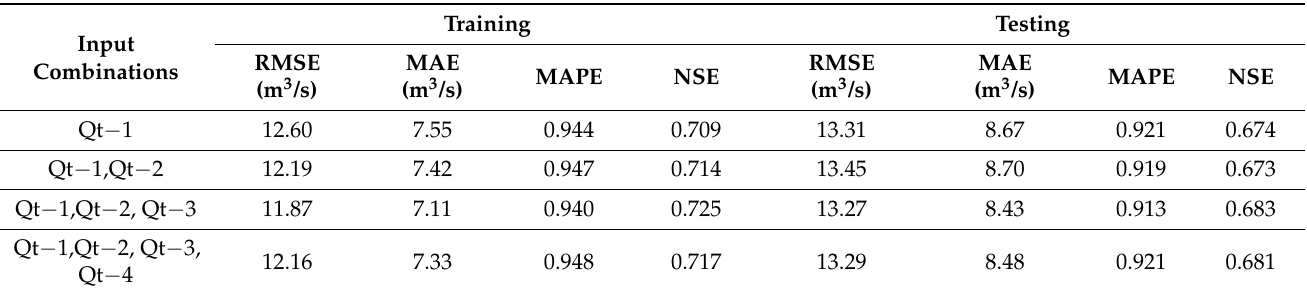
Table 2. Training and testing statistics of the MARS models using different input combinations for daily streamflow prediction—Ostavallselet